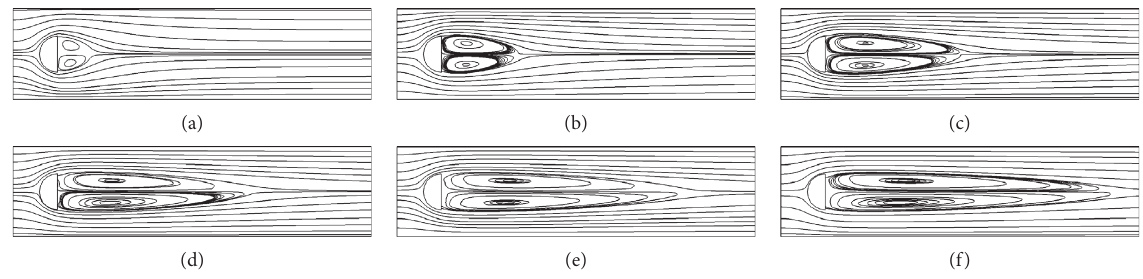
Figure 4: Streamlines of the velocity field at (a) Re � 100, (b) Re � 300, (c) Re � 600, (d) Re � 900, (e) Re � 1200, and (f) Re �